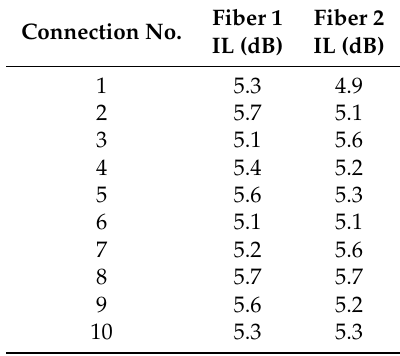
Table 2. Attenuation of the proposed connector.